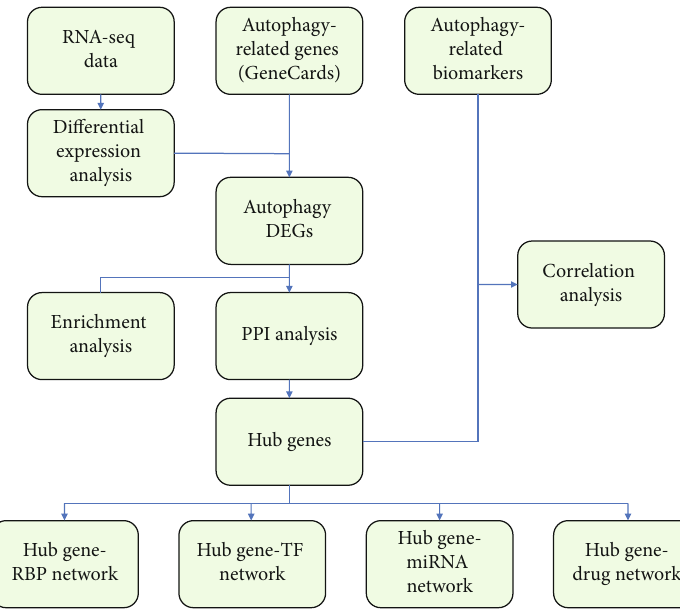
Figure 1: Schematic fl ow